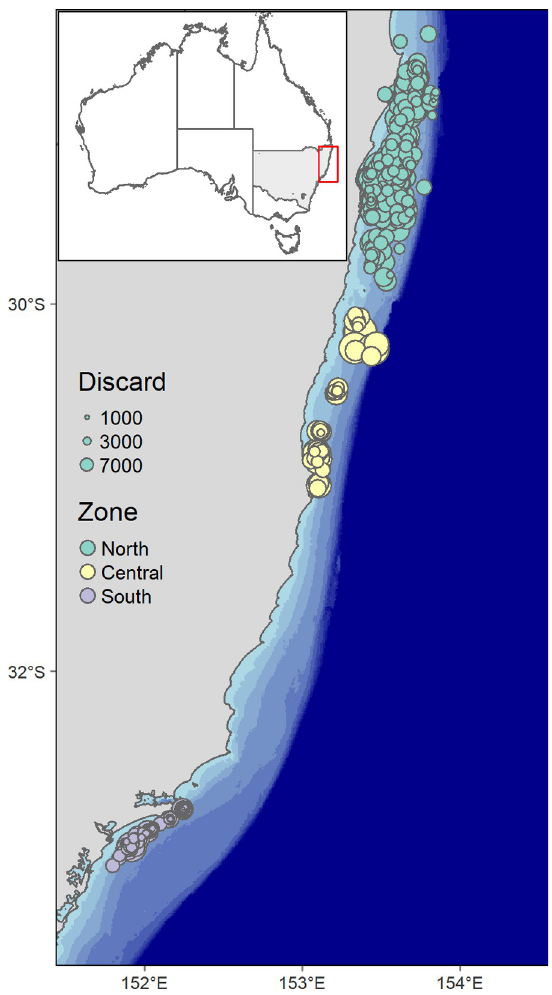
Fig 1. Study location showing the standardised discard rate (number of individuals standardised by swept area (see methods)) of all study species groups (elasmobranchs, crustaceans and fish combined) per trawl trip in all zones. Also shown are shaded depth increments (30 m). New South Wales is shown as grey in the inset. Shape and raster files used to create this image are available at